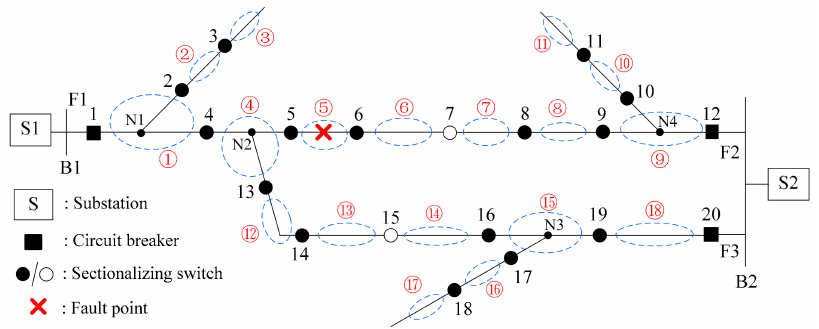
Figure 5. A fault